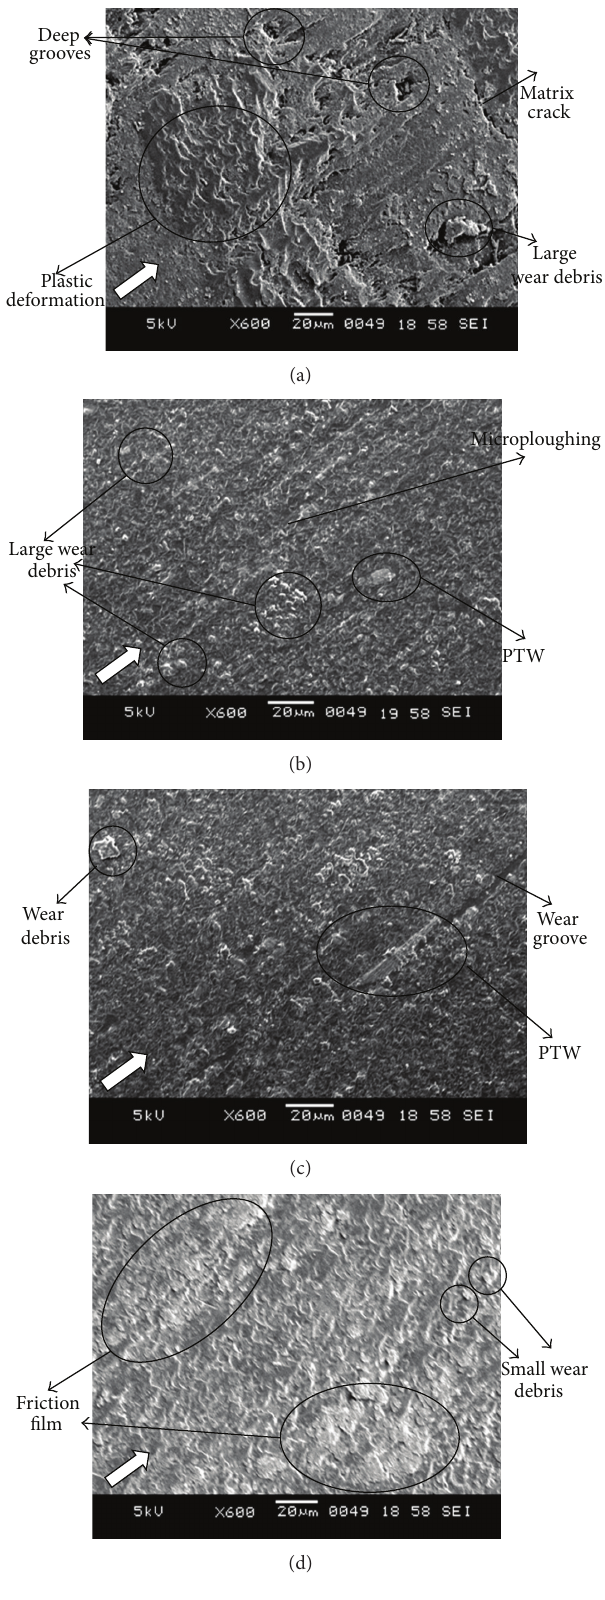
Figure 11: SEM pictures of worn-out surfaces.(a) EP0, (b) EP5, (c) EP10, and (d) EP15 samples (test conditions: load 30 N, speed 1 m/s, and distance